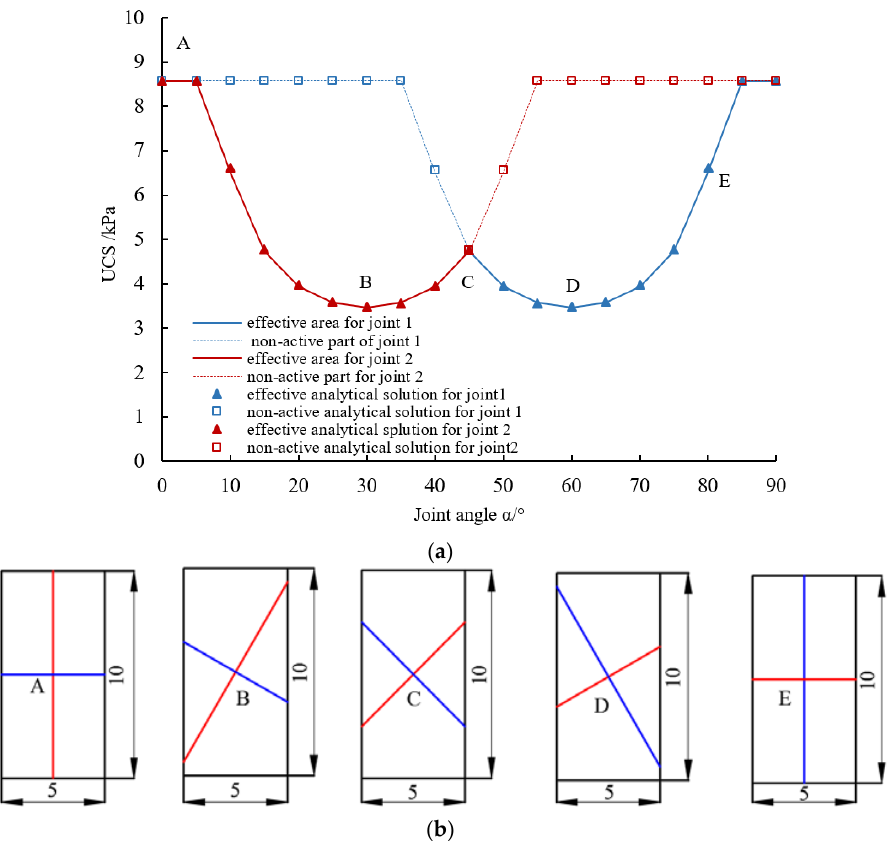
Figure 14. ( a ) Failure envelop for sample with two perpendicular joints under uniaxial compression (see Table 2); ( b ) Schematic of 5 sample with two perpendicular joints (A to E).